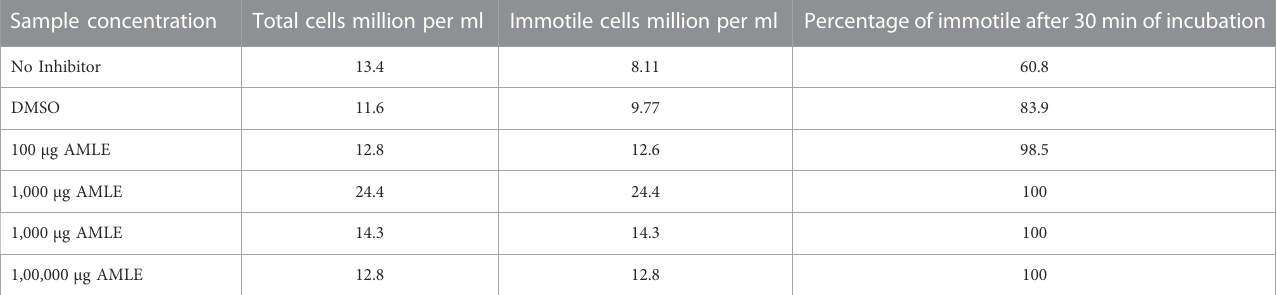
TABLE 2 Effect of different concentrations of AMLE on sperm motility after 30 min of incubation.